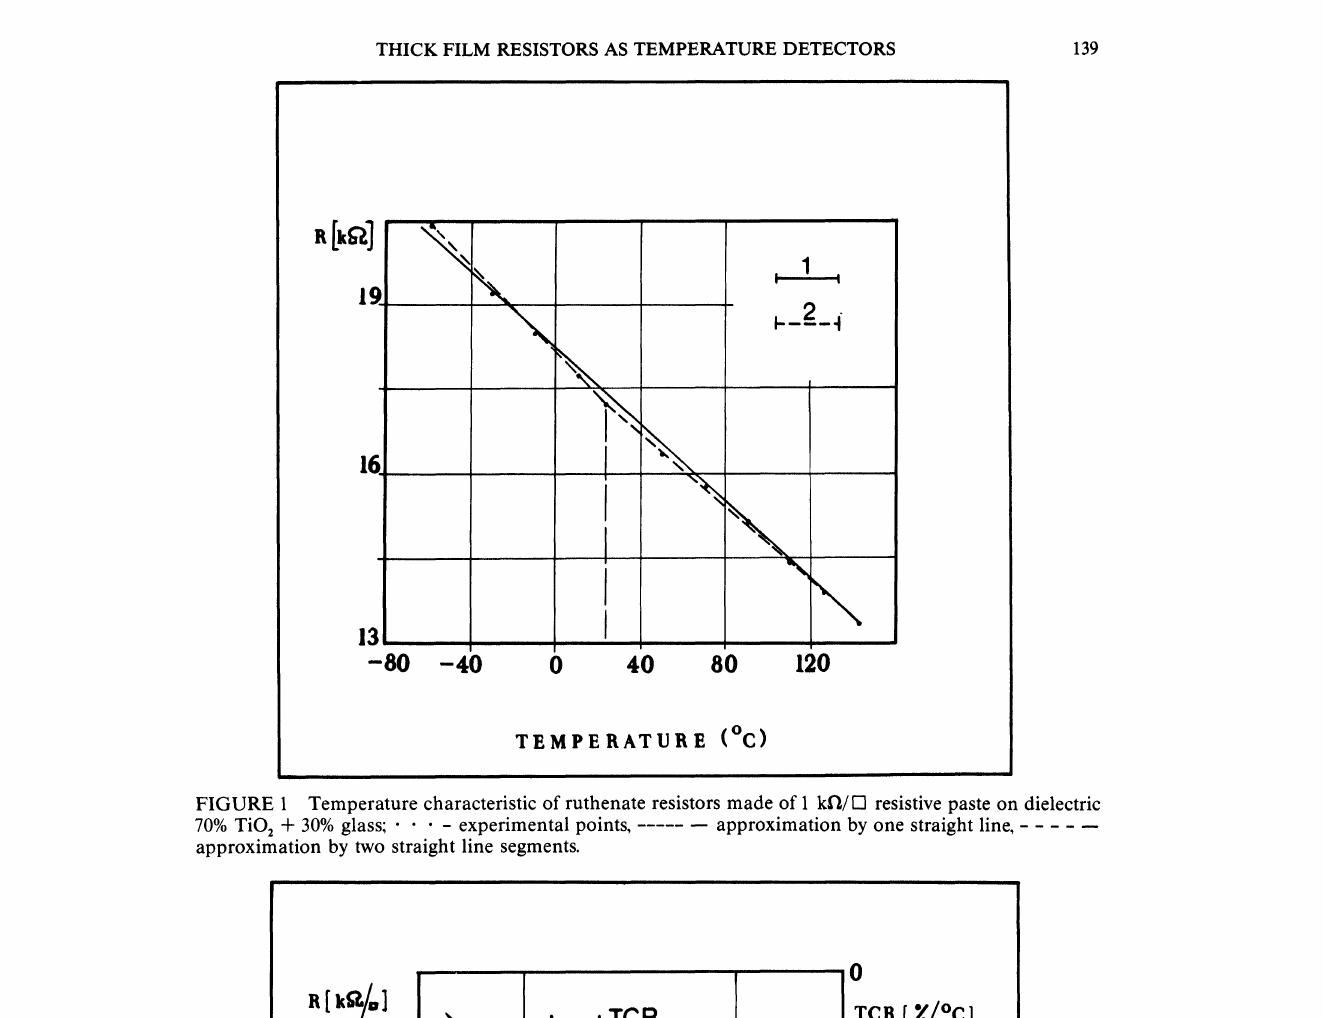
FIGURE Temperature characteristic of ruthenate resistors made of kl2/U] resistive paste on dielectric 70% TiO + 30% glass: experimental points, approximation by one straight line, approximation by two straight line segments.